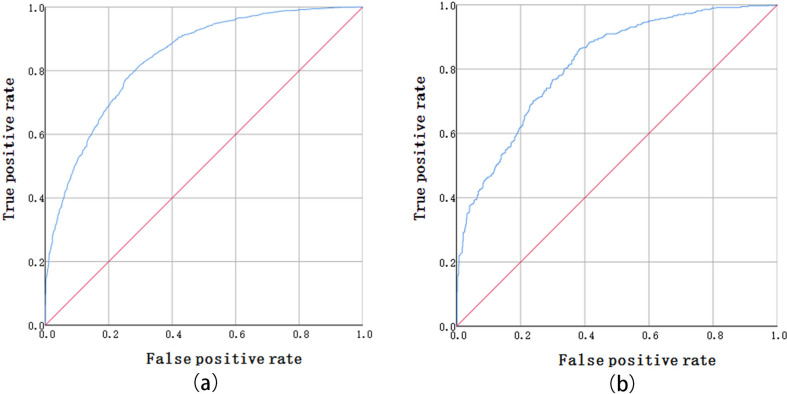
ROC curves of training samples (A) and test samples (B).